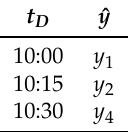
Table 5. Result of backward